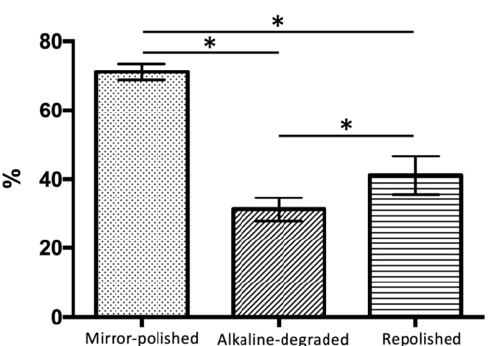
Figure 9. Glossiness. The bars (*) indicate the statistical difference (Bonferroni’s test, p < 0.001, n = 15). Table 3. Result of measurements.